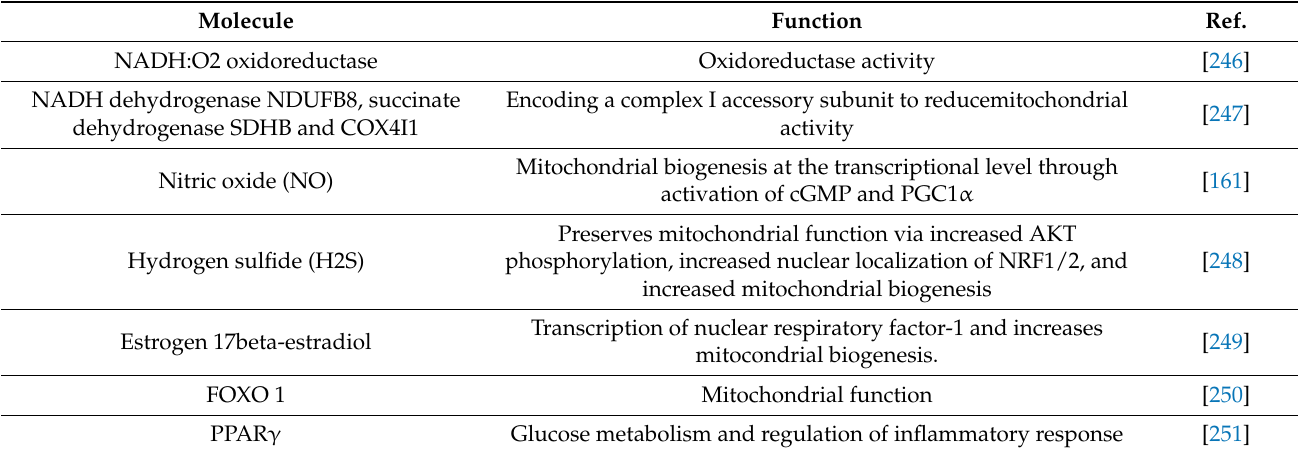
Table 3. Proteins involved in mitochondrial dysfunction in insulin resistance.